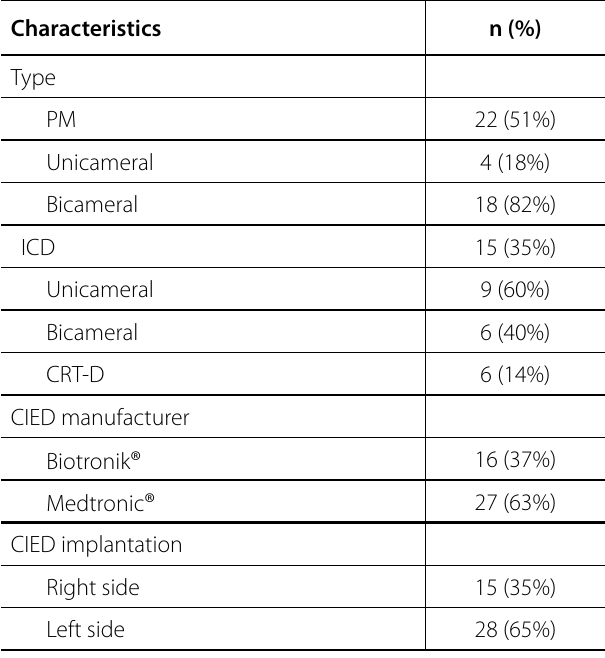
Table 2 . Characteristics of the devices implanted in the study